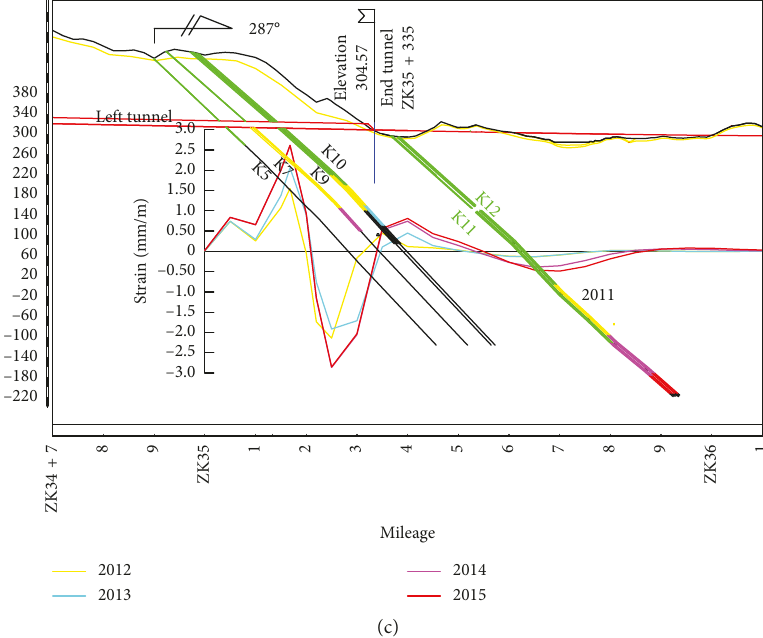
Figure 14: The left tunnel deformation. (a) Subsidence. (b) Displacement. (c) Horizontal strain along the